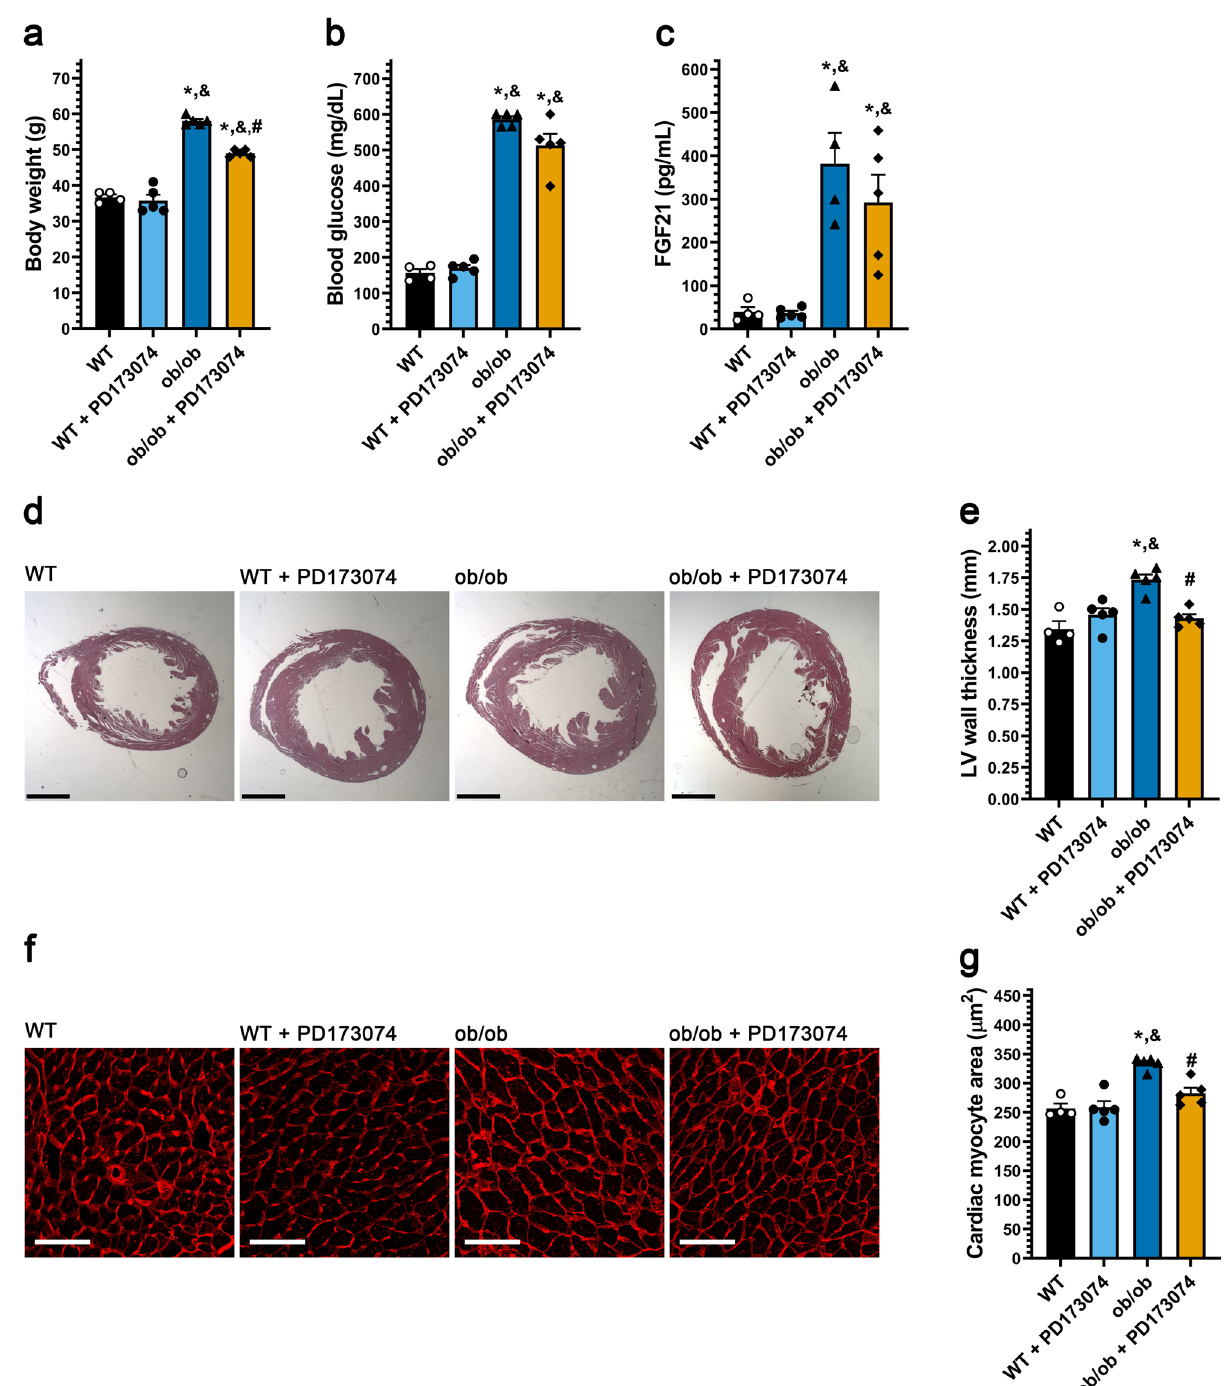
Figure 4. Systemic pan-FGFR blockade protects diabetic mice from cardiac hypertrophy. Three-month old ob/ ob and wildtype mice were injected daily with 1 mg/kg PD173074 or vehicle solution for six weeks followed by endpoint analysis. ( a ) Body weight, ( b ) blood glucose levels, and ( c ) serum FGF21 levels. ( d ) Representative images of H&E-stained transverse heart sections (scale bar = 2 mm) and ( e ) quantification of the thickness of the LV wall in these images. ( f ) Wheat germ agglutinin-stained LV tissue (scale bar = 25 µm), and ( g ) quantification of cardiac myocyte area. Comparison between groups was performed in form of a one-way ANOVA followed by a post-hoc Tukey test ( a – c , e , g ). All values are expressed as mean ± SEM. ( a – c , e , g ) N = 4–5, *p ≤ 0.05 vs. WT, & p ≤ 0.05 vs. WT + PD173074 of same age, # p ≤ 0.05 vs. ob/ob of same